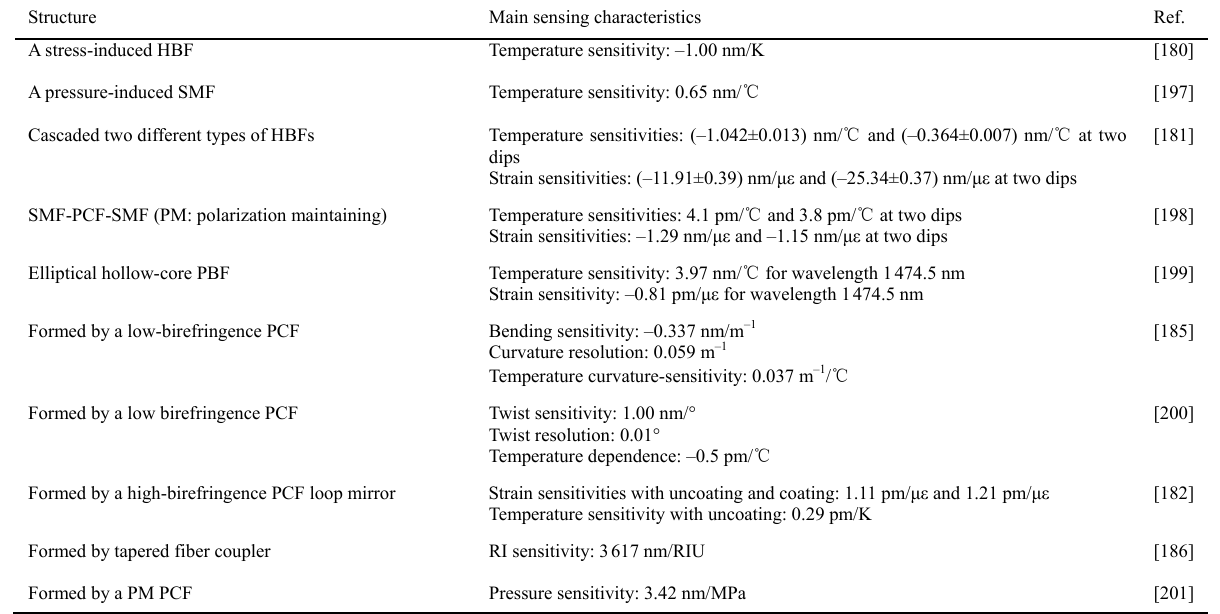
Table 8 Sensing characteristics comparison of different SI-based FOM sensors.